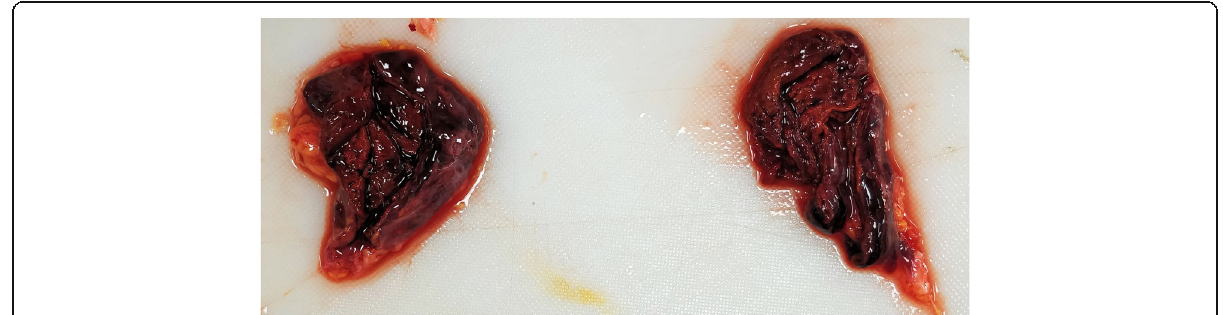
Fig. 3 Gross view of bilateral adrenal glands showing hemorrhage